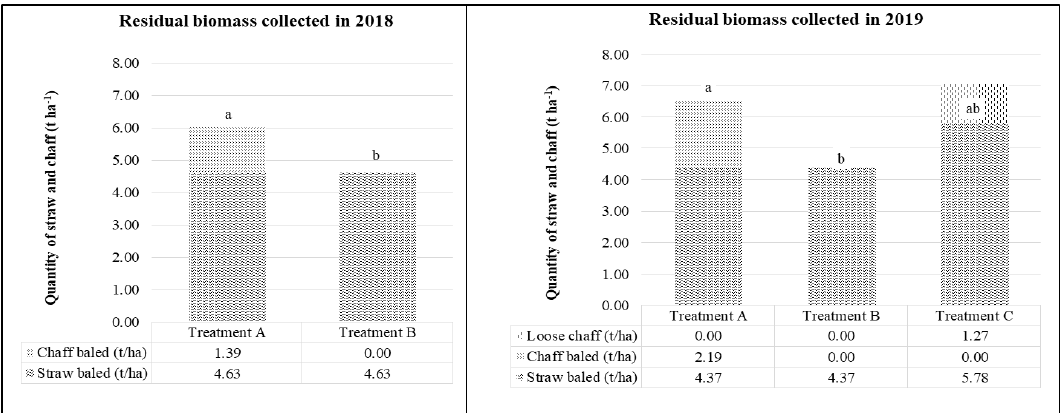
Figure 4. Biomass collected (in FM) per treatments during the tests carried out in 2018 and 2019. Treatment A—straw and chaff baling; treatment B—only straw baling (chaff spreading on the ground); and treatment C—straw baling and separate chaff collection on trailer. By including the chaff in the bales, 1.39 t FM ha-1 and 2.19 t FM ha-1 could be collected in 2018 and 2019, respectively. On the other hand, only 1.27 t ha-1 of loose chaff could be collected in the 2019 test. Different letters in the graph denote the presence of significant differences ( p < 0.05) in the quantity of straw and chaff collected among treatments.